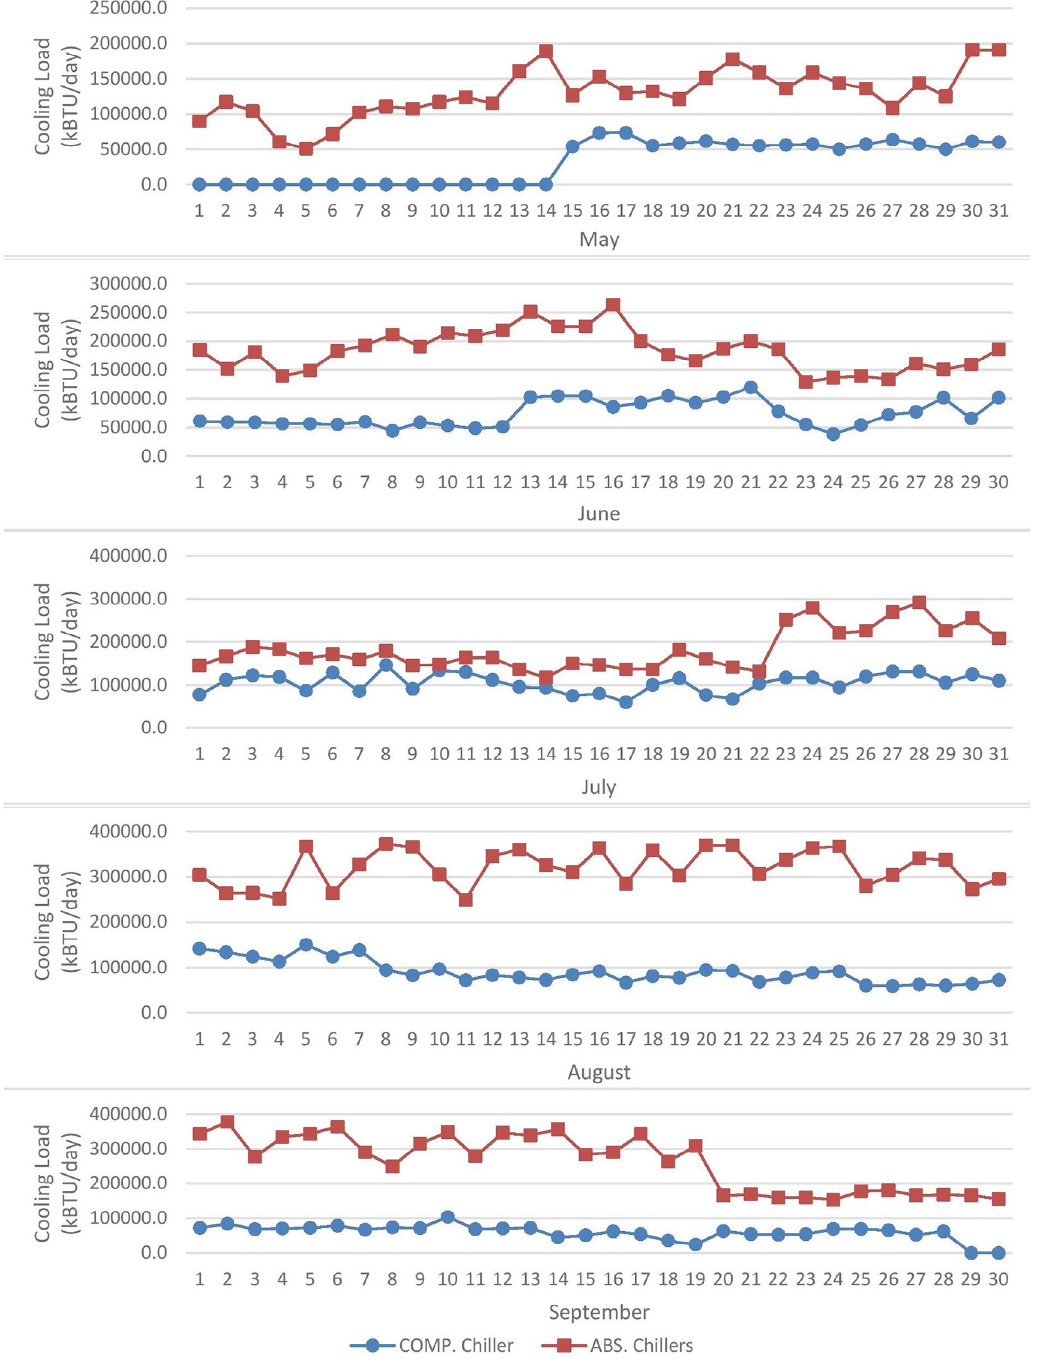
Fig. 5. Cooling rate for vapor compression and absorption chillers in May –